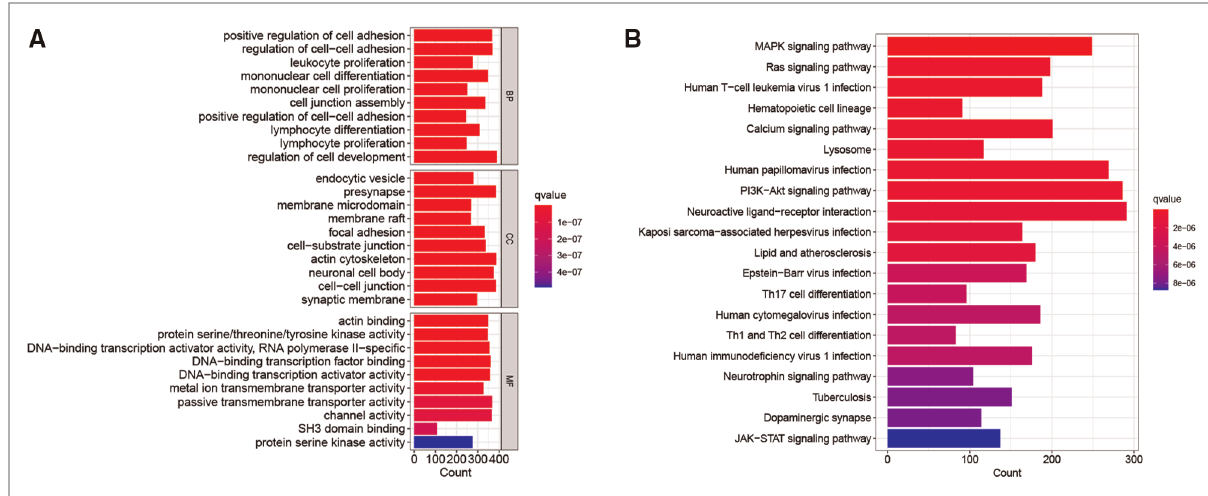
FIGURE 6 Go and KEGG enrichment analysis of differential genes. ( A ) The bar graph of the GO terms. ( B ) The bar graph of the KEGG